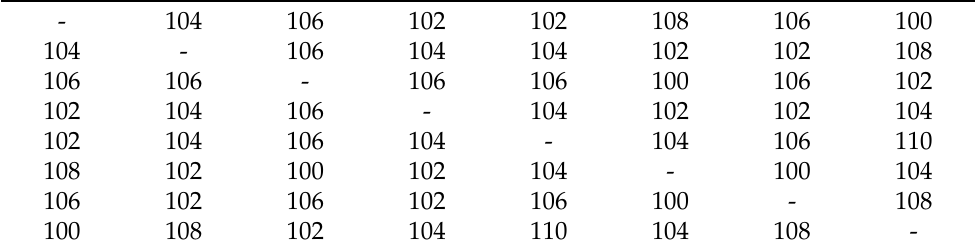
Table 6. Bits Independence Criterion (BIC) nonlinearity of the proposed S-box.